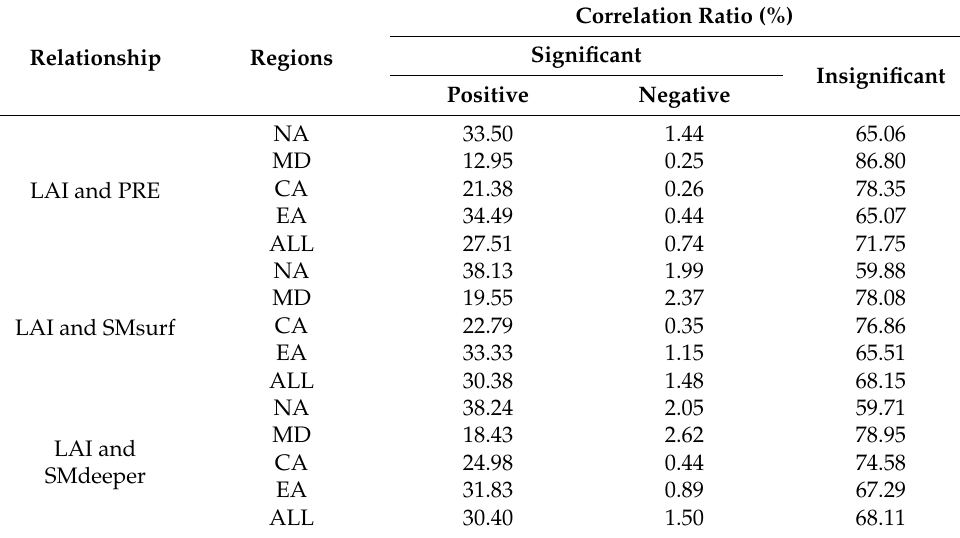
Table 2. Pearson coefficients for the relationships between the LAI and PRE, SMsurf, and SMdeeper in the four